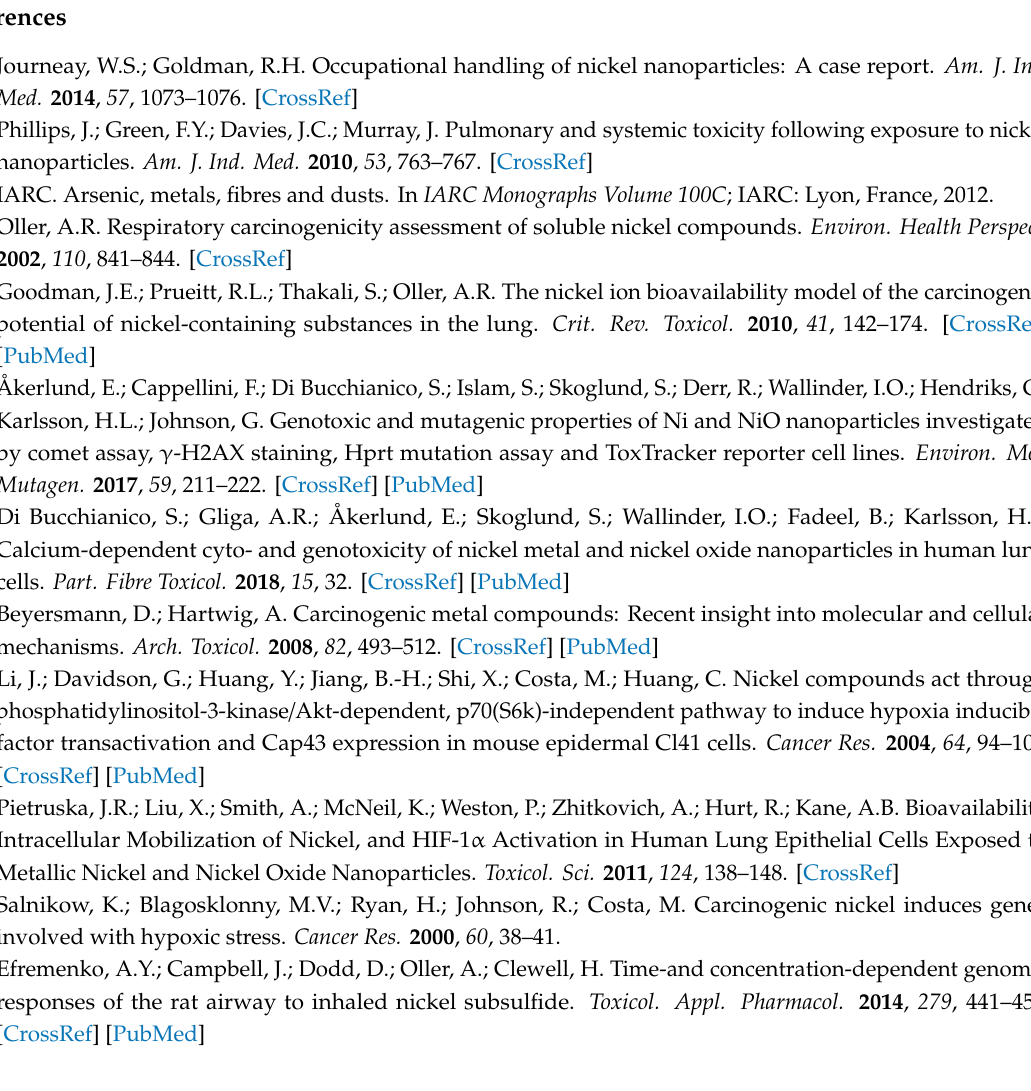
Supplementary Table S1: Upstream regulator analysis; Supplementary Figure S1: Network around top upstream regulators for NiCl 2